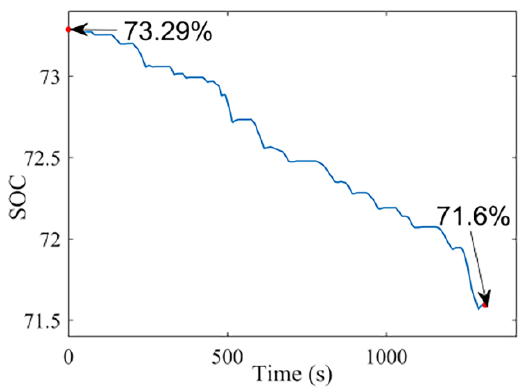
Figure 25. SOC of the shift schedule based on RL.